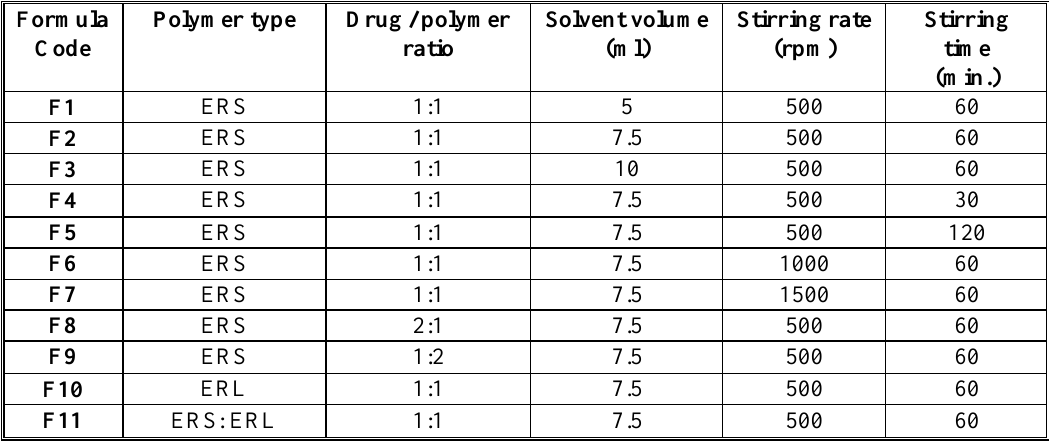
Figure 1 . The chemical structure of acyclovir Table 1 .Composition of ACV loaded